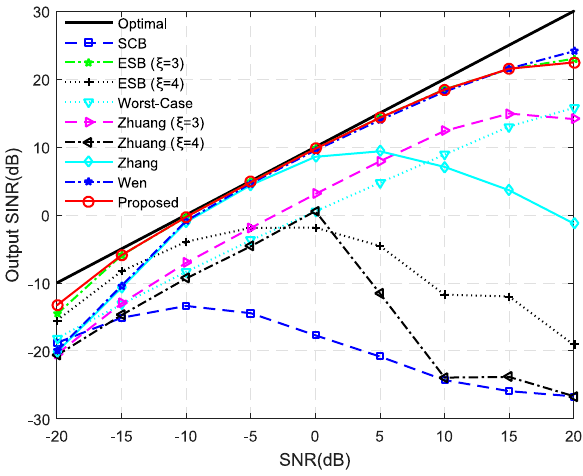
Figure 6. Output SINR versus input SNR.